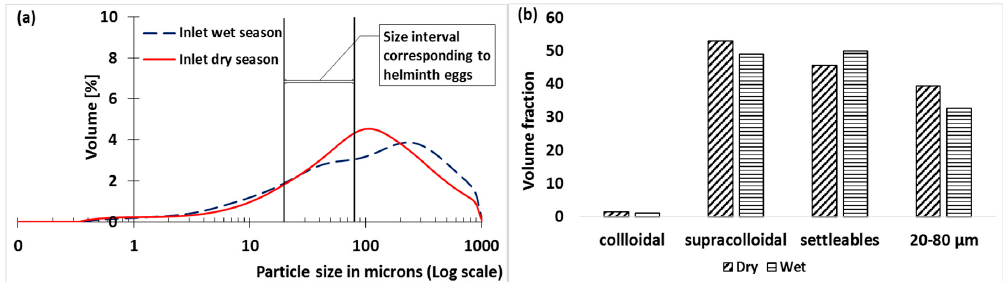
Figure 2. Incoming particle sizes for wet and dry season ( a ) volume PSD and ( b ) volume fractions of different size classes.